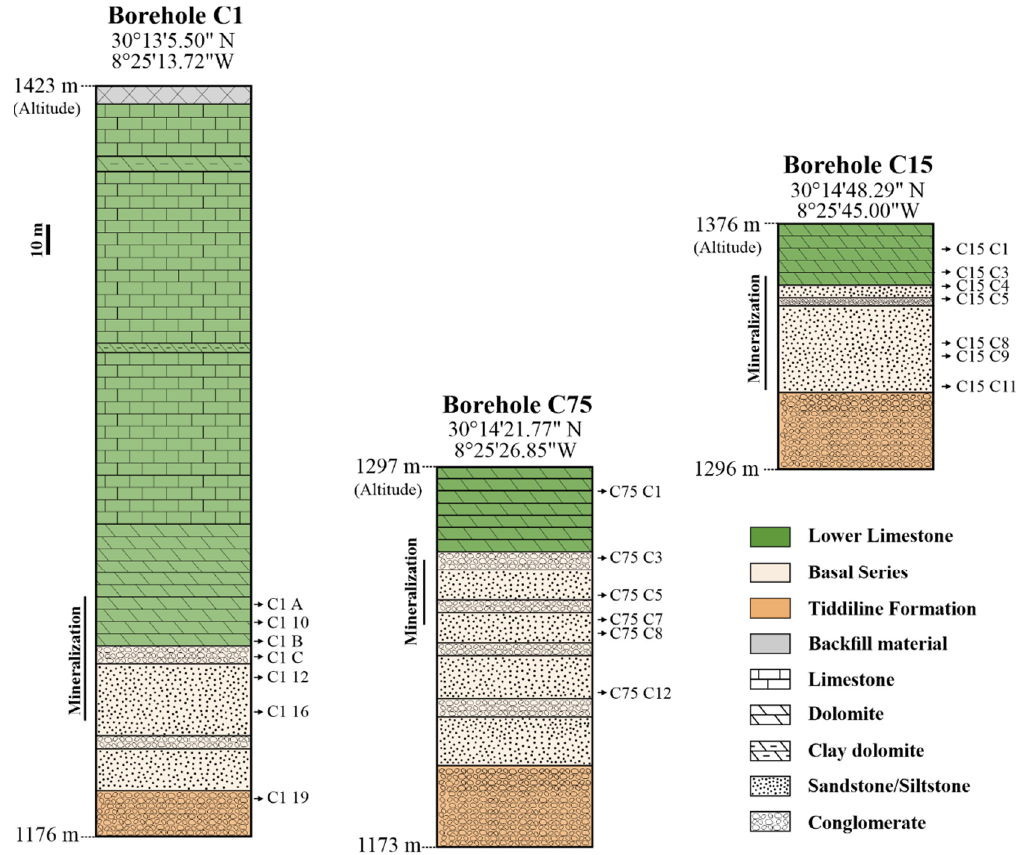
Figure 3. Schematic representation of studied boreholes (C1, C15 and C75) with different analyzed samples.